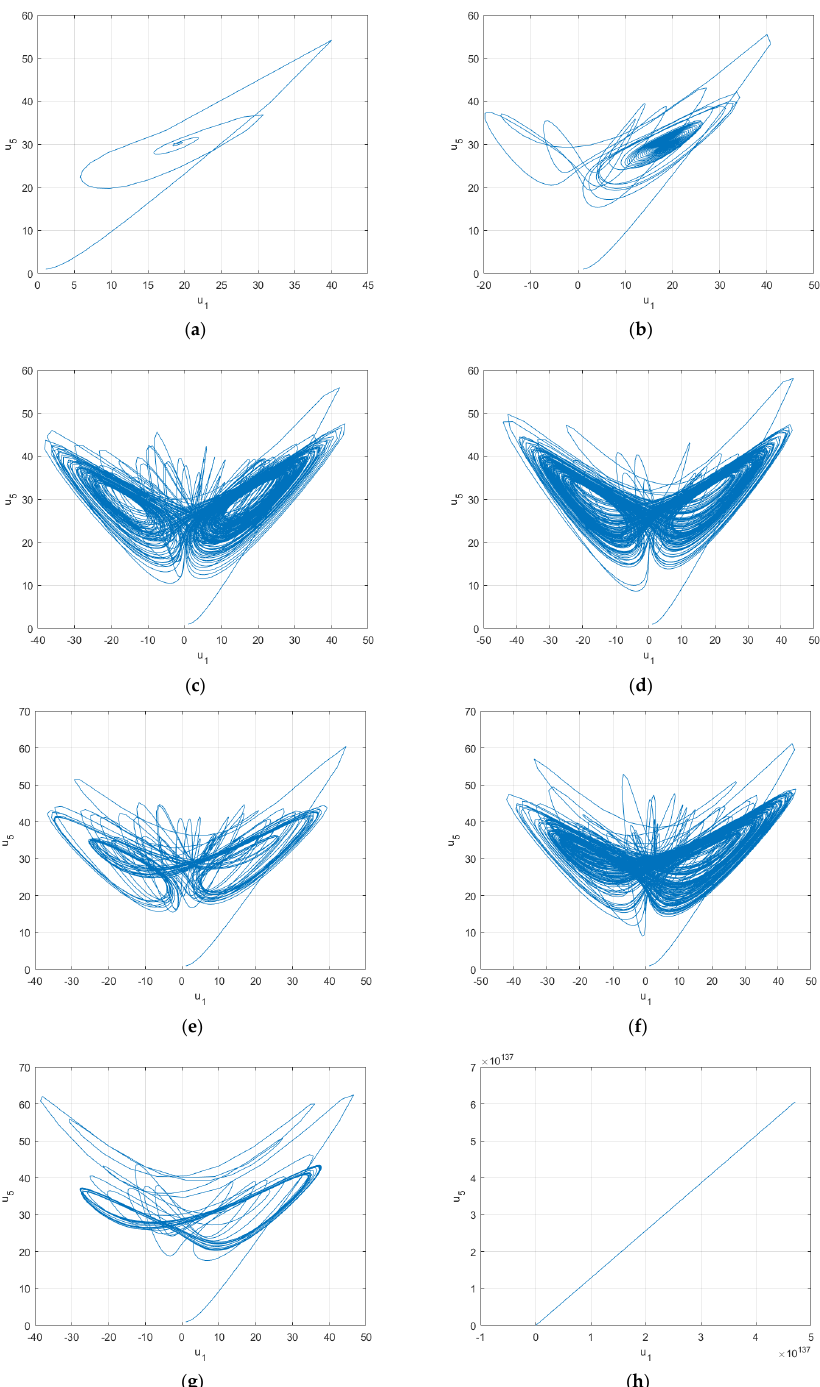
Figure 7. The evolution process of system (11) with order. ( a ) 𝛼 l(l=1,2,3,4) = 0.82 ; ( b ) 𝛼 l(l=1,2,3,4) = 0.94 ; ( c ) 𝛼 l(l=1,2,3,4) = 0.95 ; ( d ) 𝛼 l(l=1,2,3,4) = 0.99 ; ( e ) 𝛼 l(l=1,2,3,4) = 1.01 ; ( f ) 𝛼 l(l=1,2,3,4) = 1.03 ; ( g ) 𝛼 l(l=1,2,3,4) = 1.05 ; ( h ) 𝛼 l(l=1,2,3,4) = 1.07 . ( c ) α l ( l = 1,2,3,4 ) = 0.95; ( d ) α l ( l = 1,2,3,4 ) = 0.99; ( e ) α l ( l = 1,2,3,4 ) = 1.01; ( f ) α l ( l = 1,2,3,4 ) = 1.03; ( g ) α l ( l = 1,2,3,4 ) = 1.05; ( h ) α l ( l = 1,2,3,4 ) =